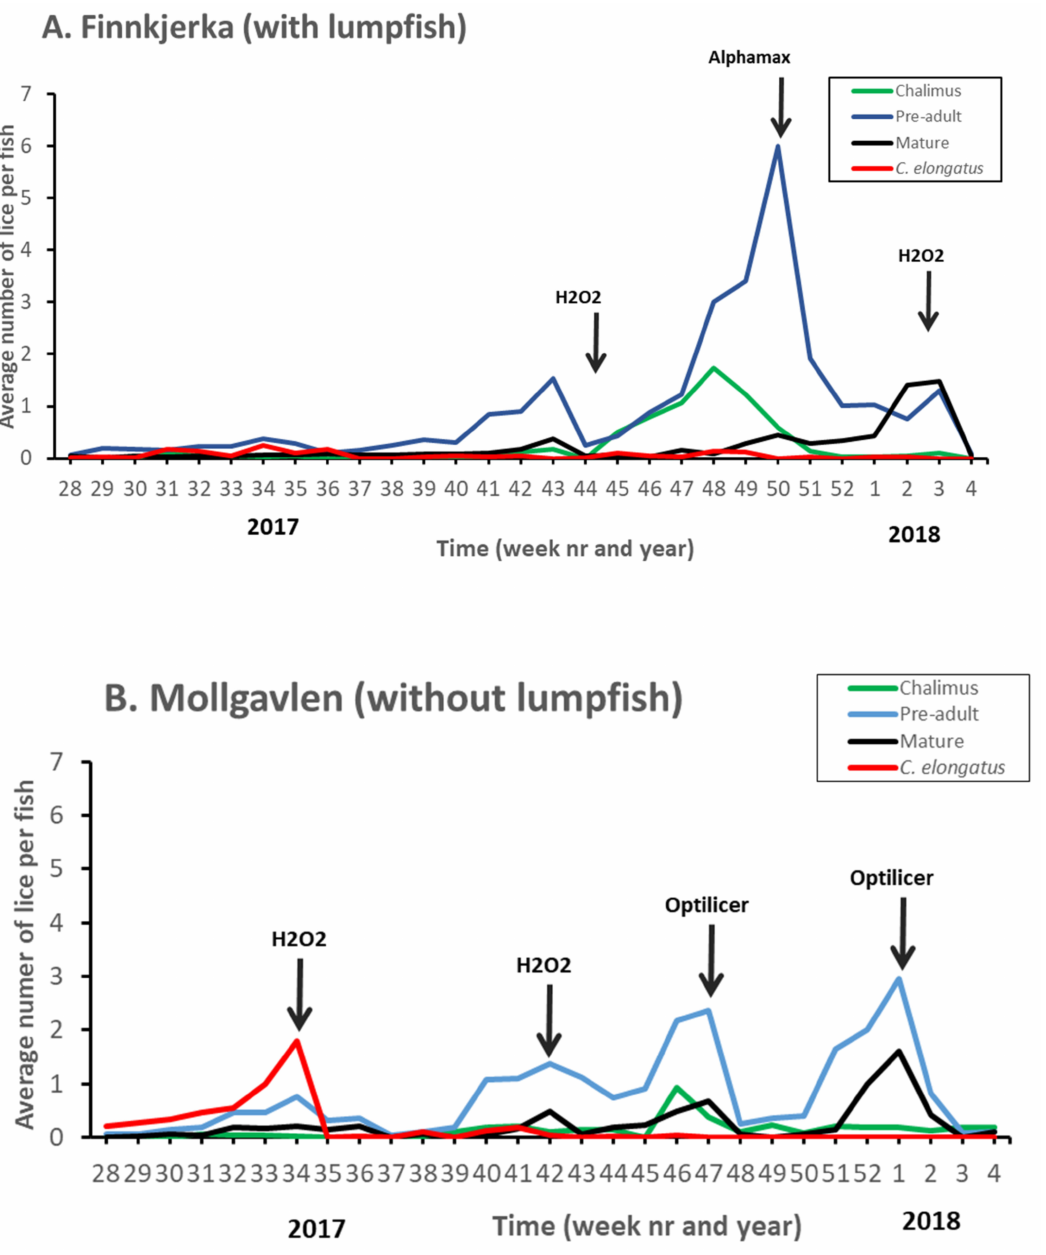
Figure 5. Sea lice development at two production sites of Nordlaks in northern Norway 2017–18 with lumpfish ( A ) and without lumpfish ( B ) in sea pens with Atlantic salmon. Arrows indicate mechanical (Optilicer ® ) and chemotherapeutical (H 2 O 2 (hydrogen peroxide), AlphaMax™) delousing operations during the observation period. Previously unpublished